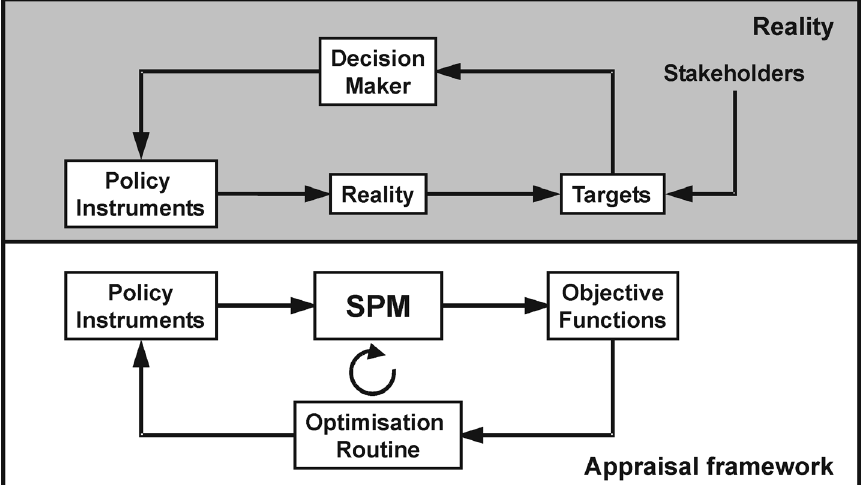
Figure 1: Framework for policy assessment (Emberger,